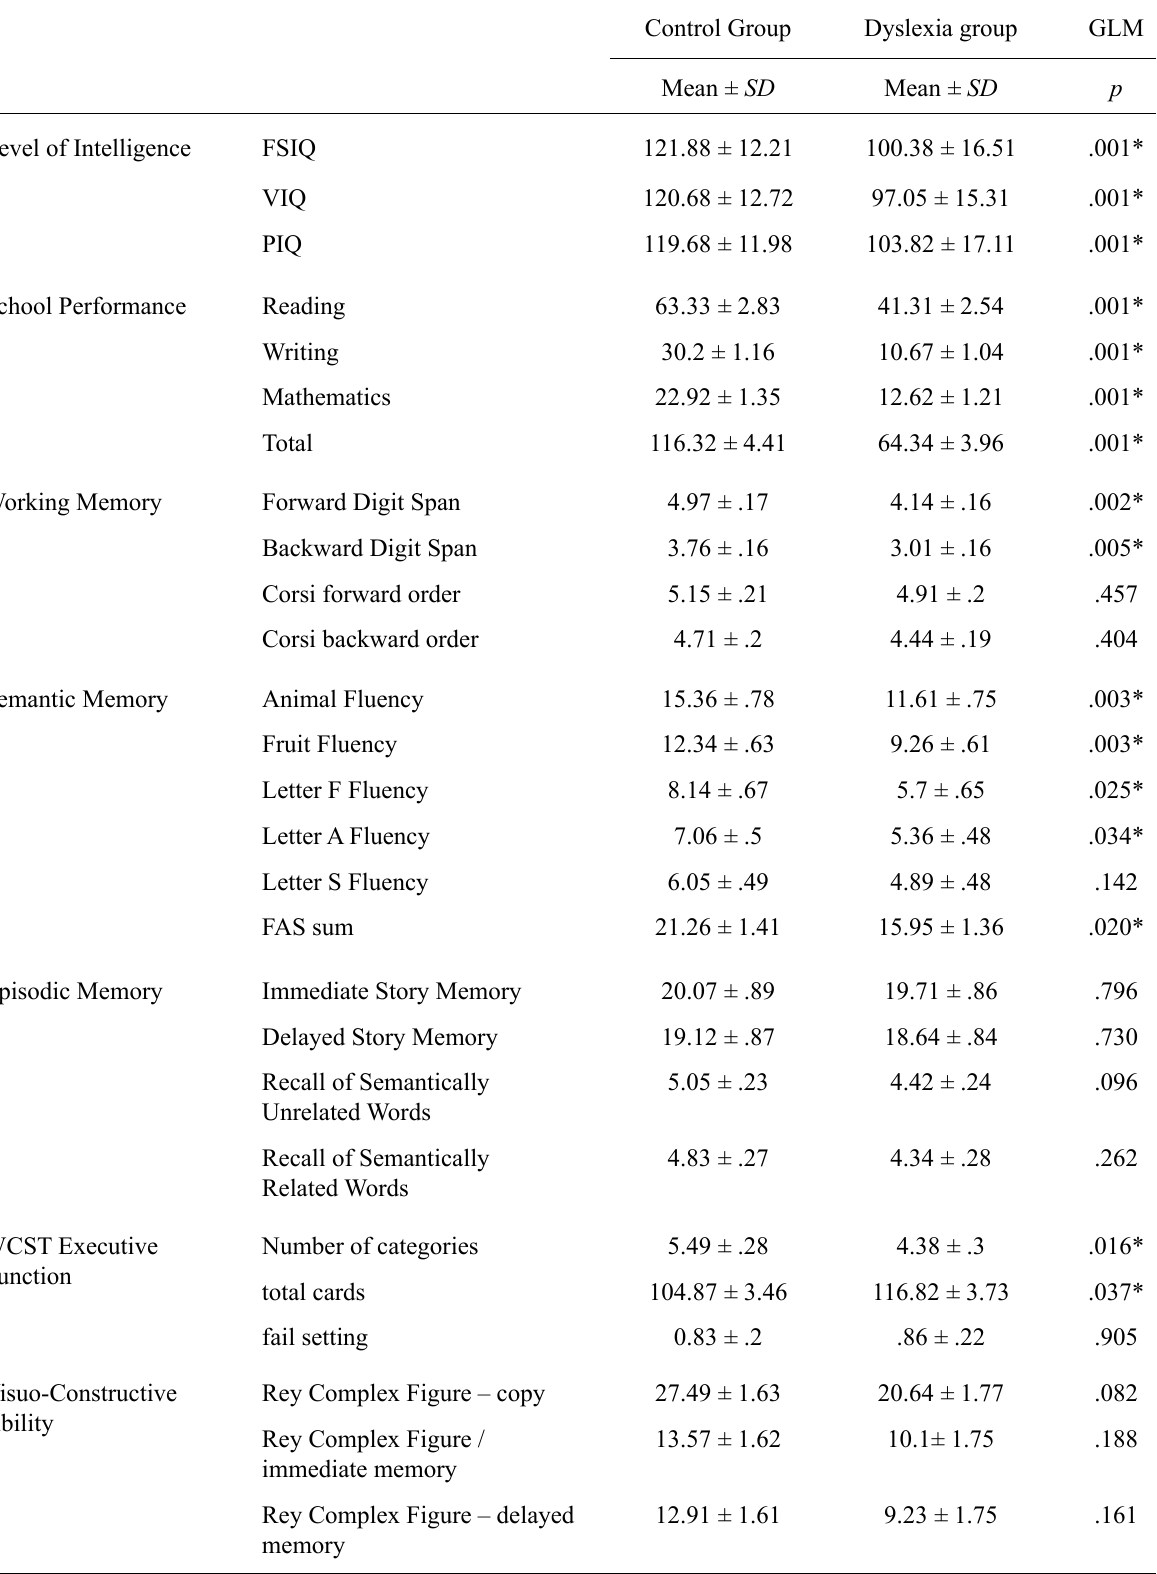
Table 1 Mean (± standard desviation) with Covariance of Full Scale Intellectual Quocient of Neuropsychological Variables (General Linear